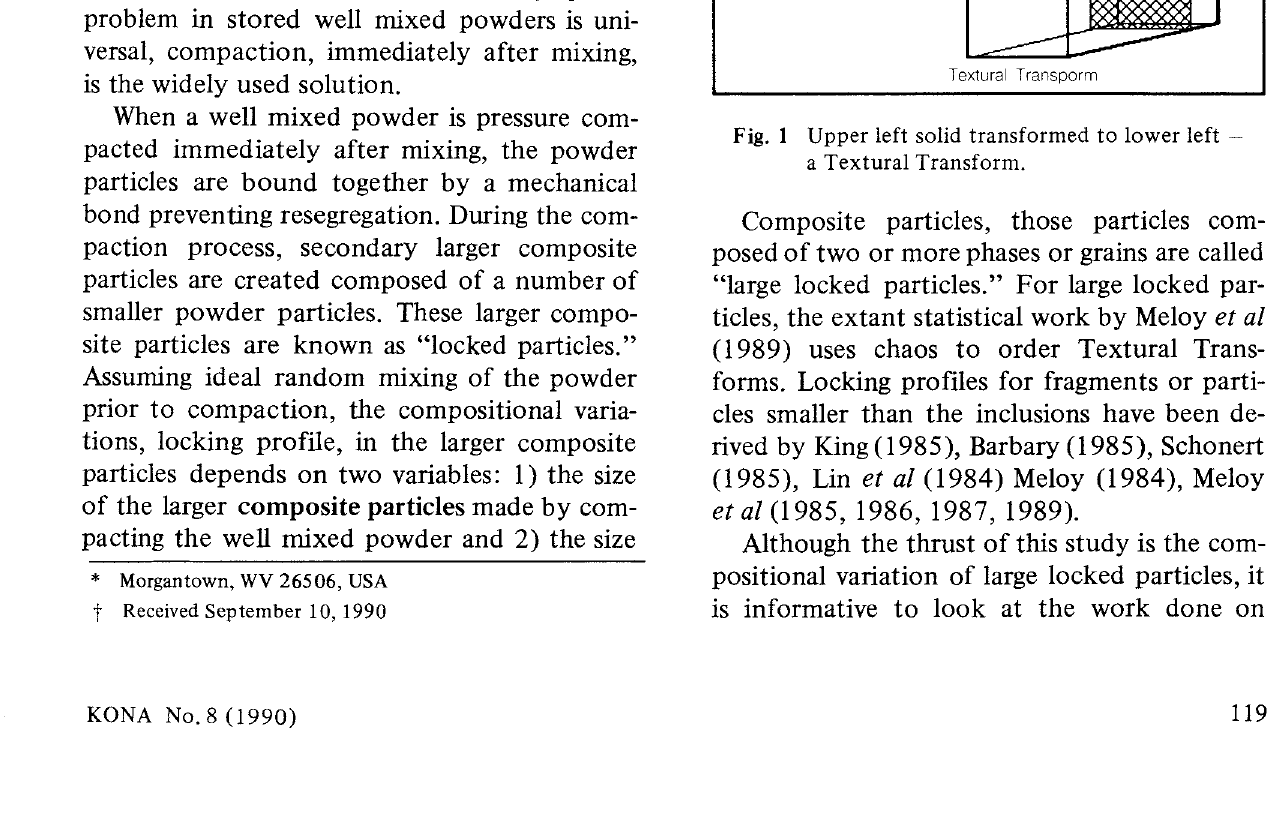
Fig. 1 Upper left solid transformed to lower left - a Textural